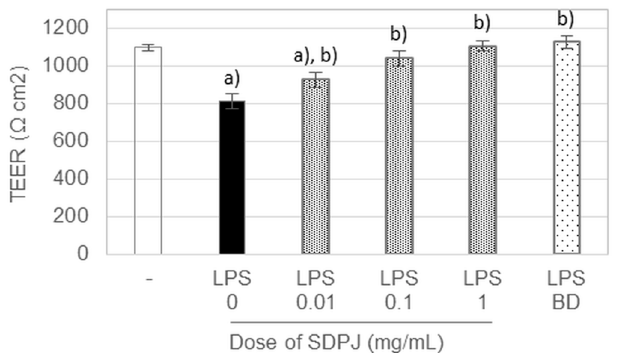
Figure 2. Effect of spray-dried potato juice (SDPJ) and budesonide (BD) on TEER values determined in a co-culture system of Caco-2 cells and RAW264.7 macrophages nonstimulated ( − ) or stimulated by lipopolysaccharides (LPS). Values represent the means ± SD ( n = 3). a) p < 0.05 vs the untreated group. b) p < 0.05 vs the LPS-treated group.